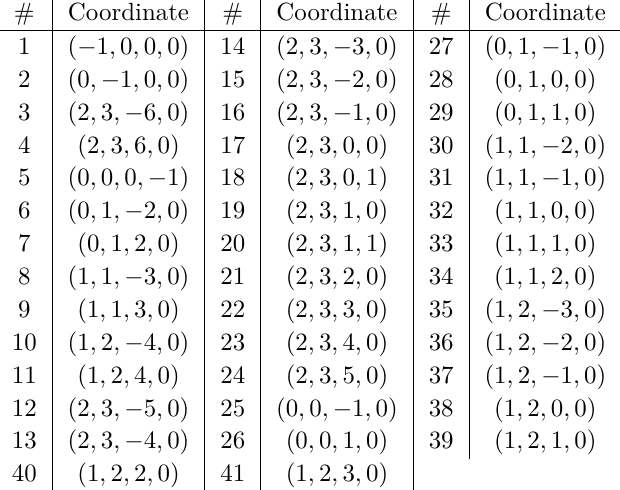
Table 1 . The rays in ∆ .